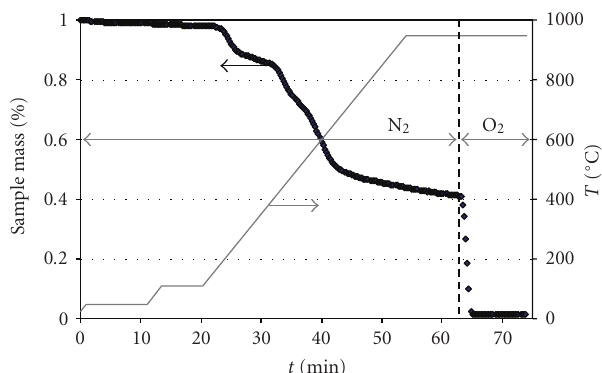
Figure 4: Typical sample mass and temperature histories during proximate analysis procedure.